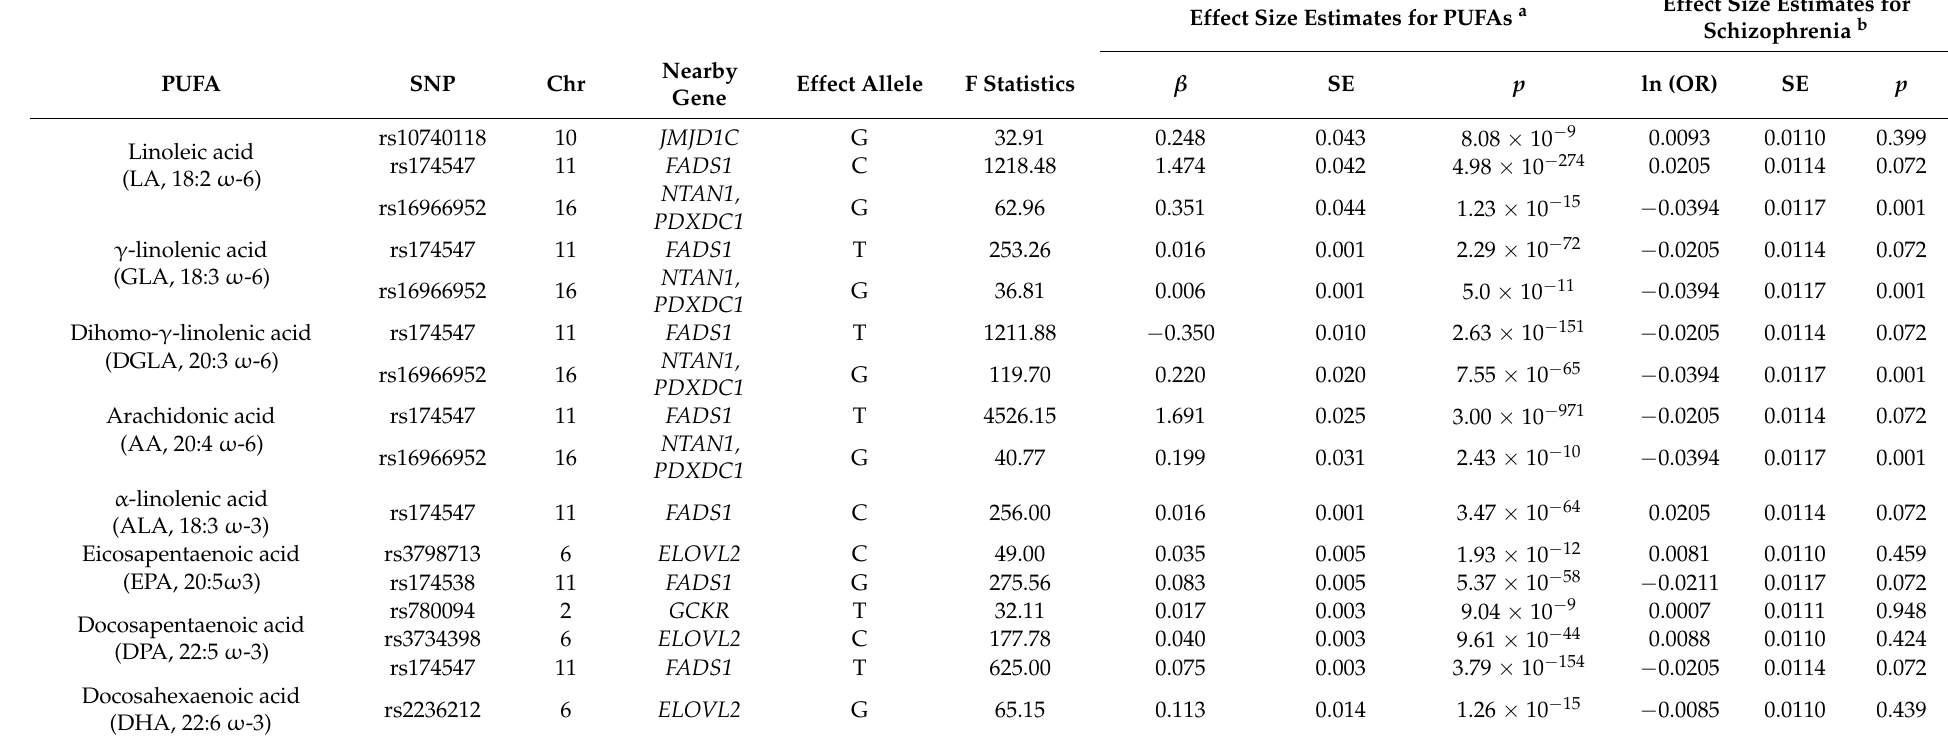
Table 3. The instruments of eight PUFAs and schizophrenia in MR